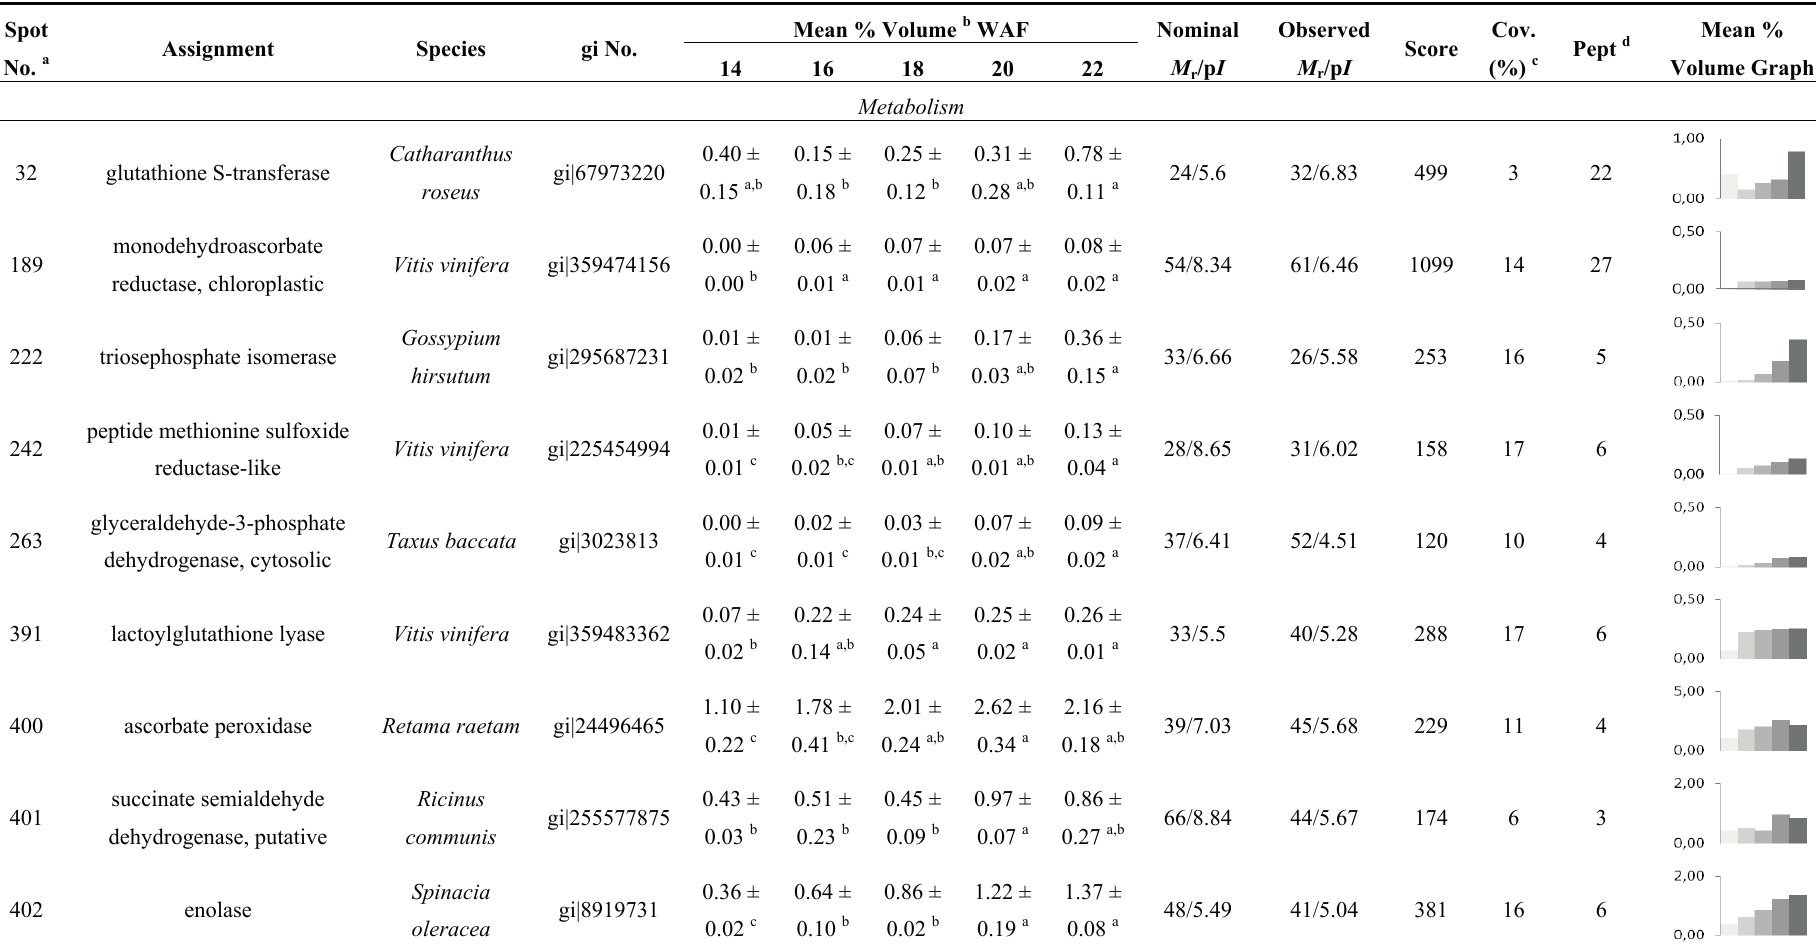
Table 2. Identification of proteins in Acer platanoides that significantly changed in abundance during the period of embryo maturation. For each spot, values for nominal (computed) and observed p I s and M and the mean normalized volume of each of the analyzed variants are r indicated. Spots were subjected to ANOVA and the Tukey-Kramer HSD test (SAS Institute) to select spots that significantly varied ( p < 0.05) in abundance during